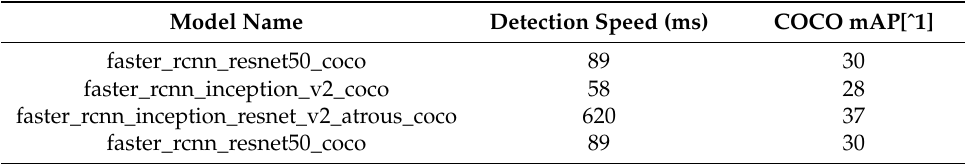
Table 1. Comparison between different Faster R-CNN models [30].